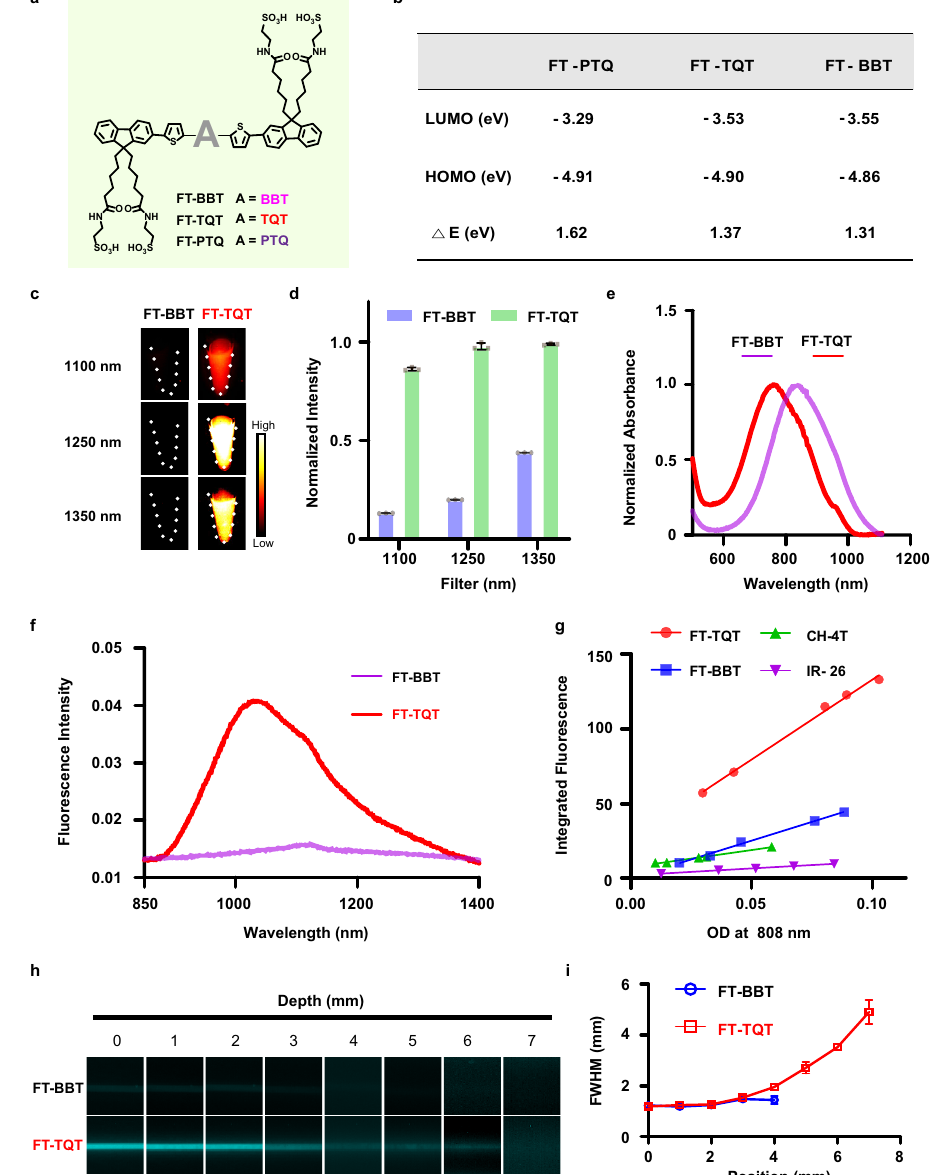
Fig. 3 Optical characterization of NIR-II FTs. a The structure of FT-BBT, FT-TQT, and FT-PTQ. b Theoretical calculations for the investigation of photophysical properties. c NIR-II fl uorescent images of FT-BBT and FT-TQT in deionized water at equivalent absorbance of OD 0.1 at 808 nm with 1100, 1250, and 1350 nm long-pass (LP) fi lters. d Normalized fl uorescent intensity of FT-BBT and FT-TQT in c with different fi lters. Data are presented as mean ± s.d. derived from n = 3 independent detections. e Normalized Absorption spectrum of FT-BBT and FT-TQT in deionized water. f The fl uorescence emission spectrum of FT-BBT and FT-TQT in deionized water at an equivalent concentration of 10 µ M. g Plot of the integrated fl uorescence spectrum of FTs and CH-4T at fi ve different concentrations in methanol due to low quantum yield in water. Linear fi ts were used to calculate quantum yield by comparing the slopes to reference IR-26 (QY = 0.05%). h Fluorescence images of capillaries fi lled with FT-BBT and FT-TQT in PBS (pH 7.4), respectively, immersed in 1% Intralipid with varying depth. Imaging signals were collected in the 1300 nm region under 808 nm excitation. i Wavelength-dependent full- width at half-maximum (FWHM) of cross-sectional pro fi les in capillary images as a function of depth. The bars represent mean ± s.d. derived from n = 3 independent measurements. The detailed imaging parameters for each image are listed in Supplementary Table